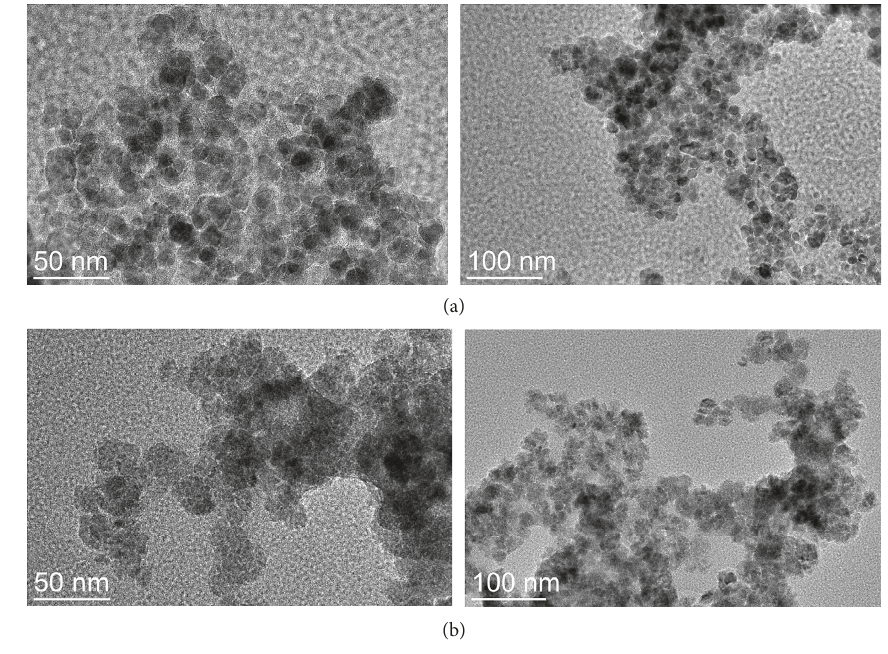
Figure 3: TEM images of (a) MNPs and (b) APTES@MNPs.